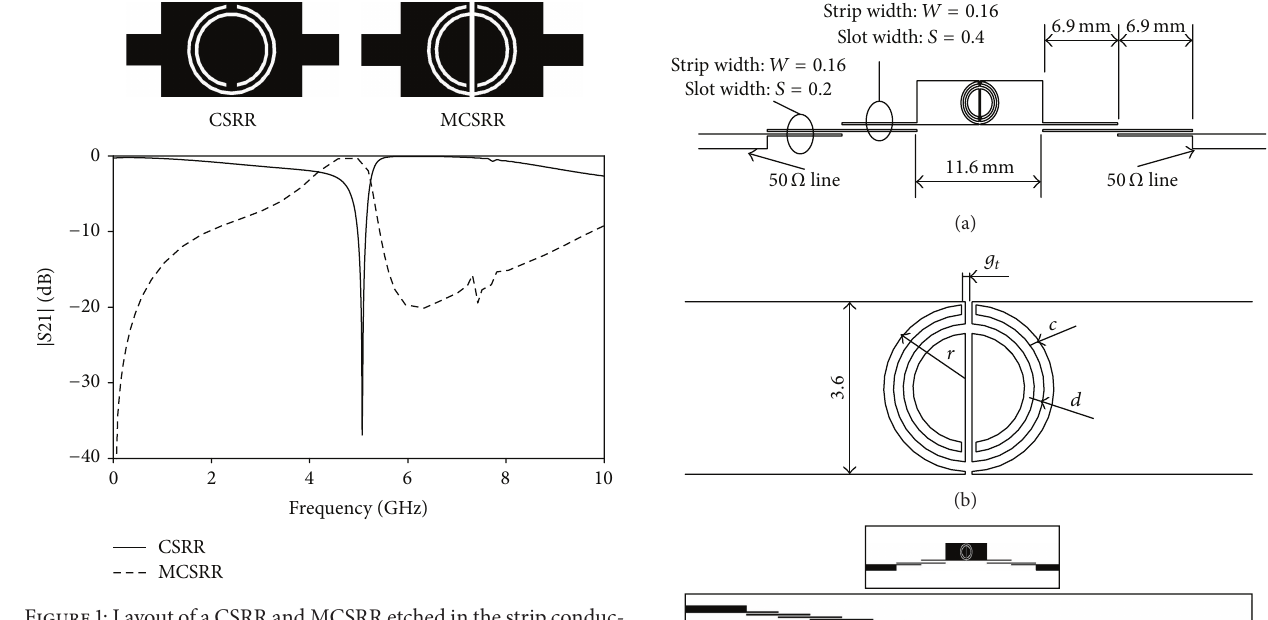
Figure 1: Layout of a CSRR and MCSRR etched in the strip conduc- tor of a microstrip line and simulated S21 for CSRR (solid line) and MCSRR (dashed line).